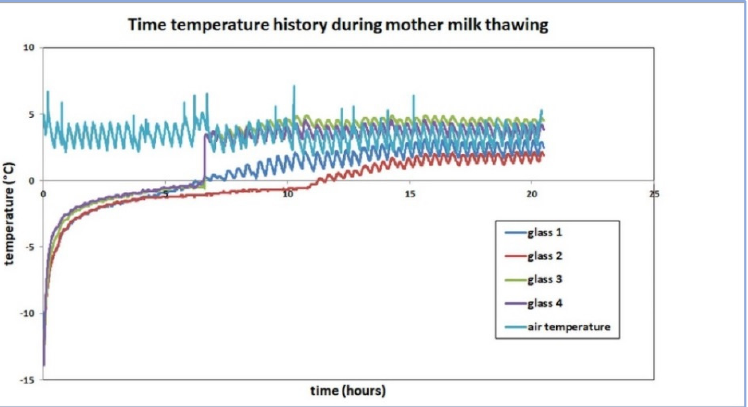
Figure 5. The temperature history of slow thawing of four 100 mL frozen PBM bottles in a refrigerator.